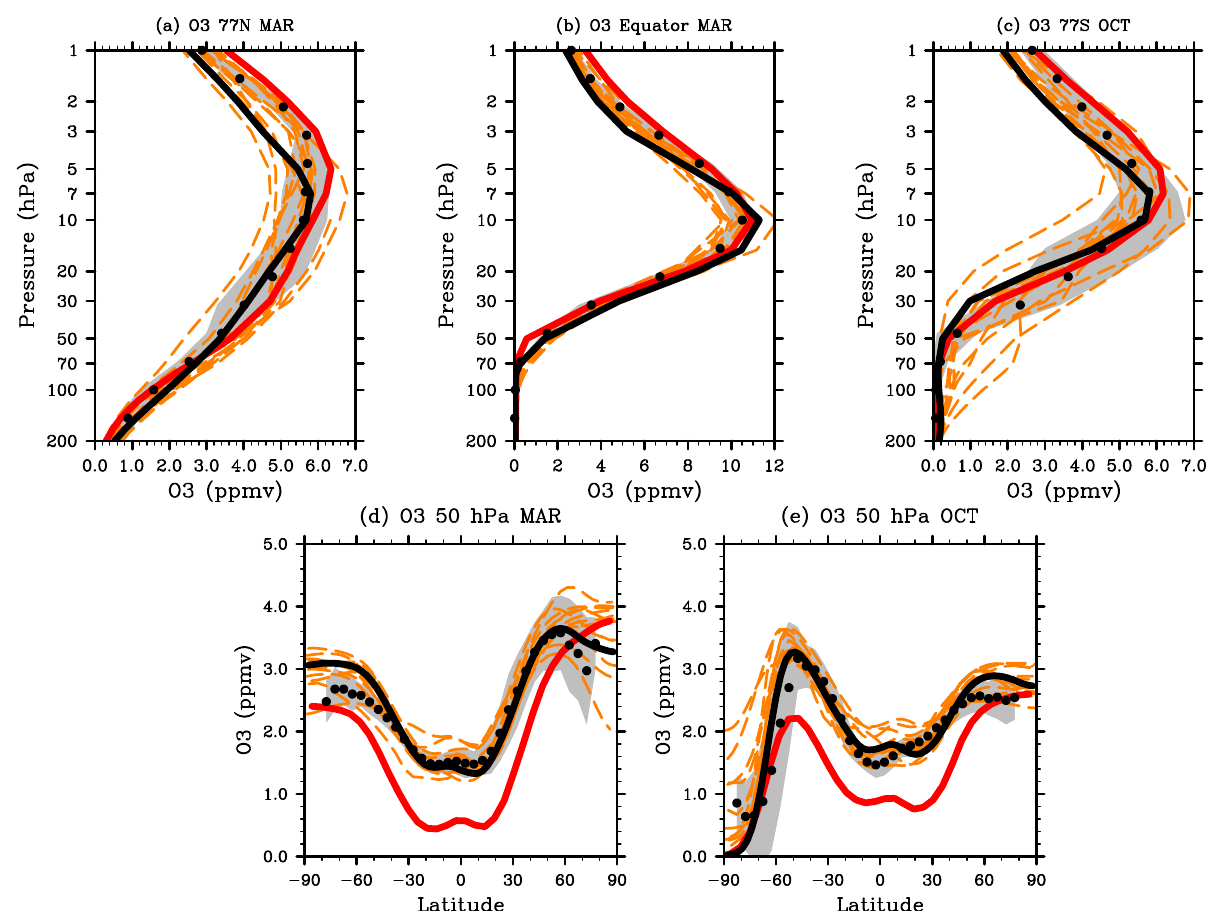
Fig. 11. Climatological (1992–2001) zonal-mean O 3 mixing (ppmv), for HALOE observations (black dots, with grey area showing ± 1 σ ), CNRM-ACM (red line), CNRM-CCM (black line), and CCMVal-2 REF-B1 models (dashed orange lines). Vertical profiles at (a) 77 ◦ N in March, (b) 0 ◦ N in March, and (c) 77 ◦ S in October. Zonal-means at 50 hPa in (d) March and (e) October.